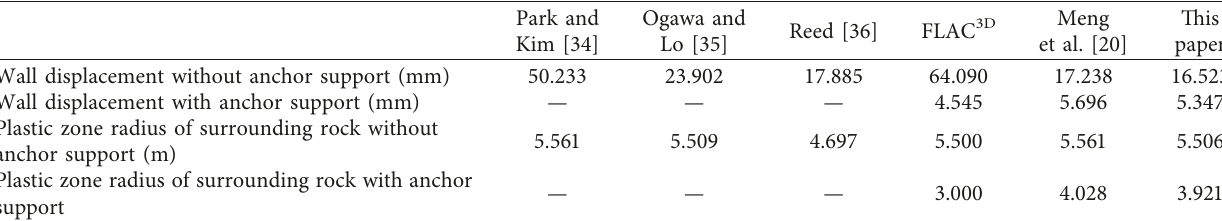
Table 5: Comparison of results from different authors. Park